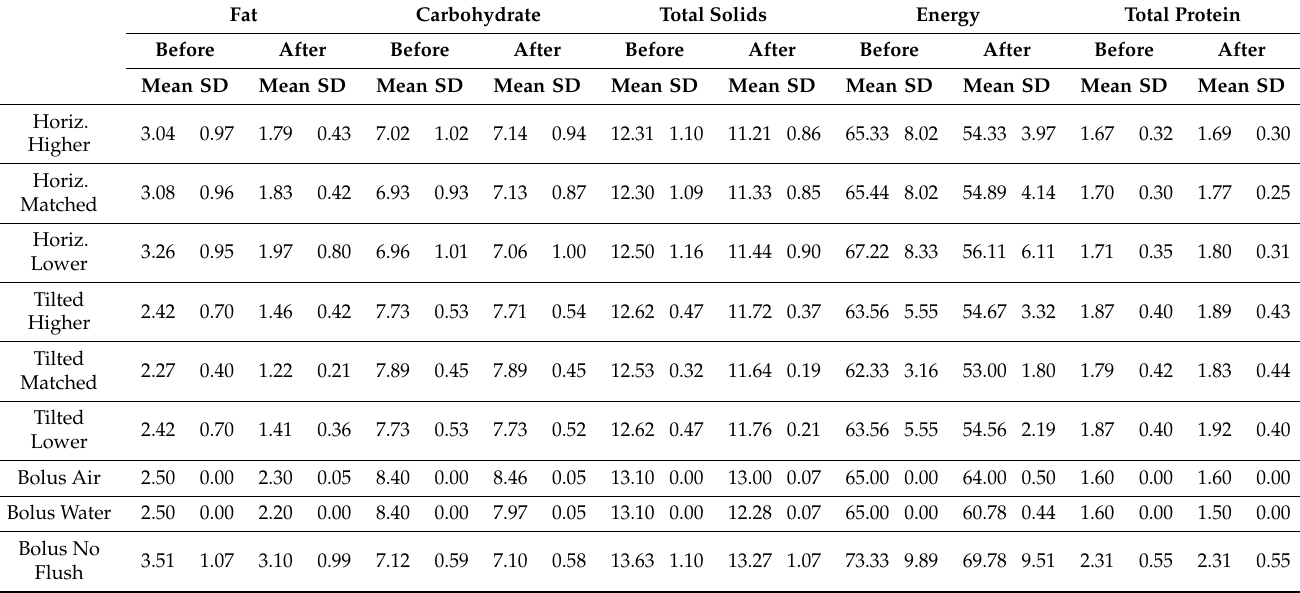
Table 1. Average mass concentration of macronutrients before and after feeding simulations (n = 9). Fat Carbohydrate Total Solids Energy Total Protein Before After Before After Before After Before After Before After Mean SD Mean SD Mean SD Mean SD Mean SD Mean SD Mean SD Mean SD Mean SD Mean SD Horiz.